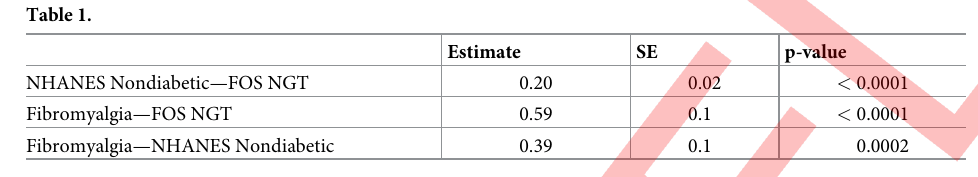
norepinephrine reuptake inhibitors (amitriptyline, duloxetine or milnacipran) and/or mem- brane stabilizing agents (gabapentin or pregabalin), depending on tolerability or patients’ pref-